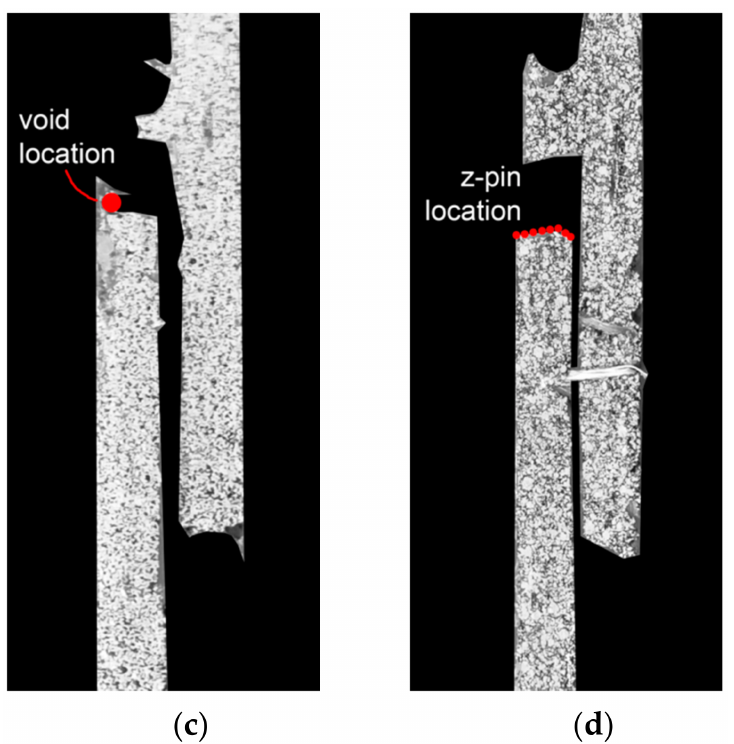
Figure 15. Post-failure images of representative ( a ) VTFA400 specimens ( b ) cured and bonded ( c ) co-cured; and ( d )